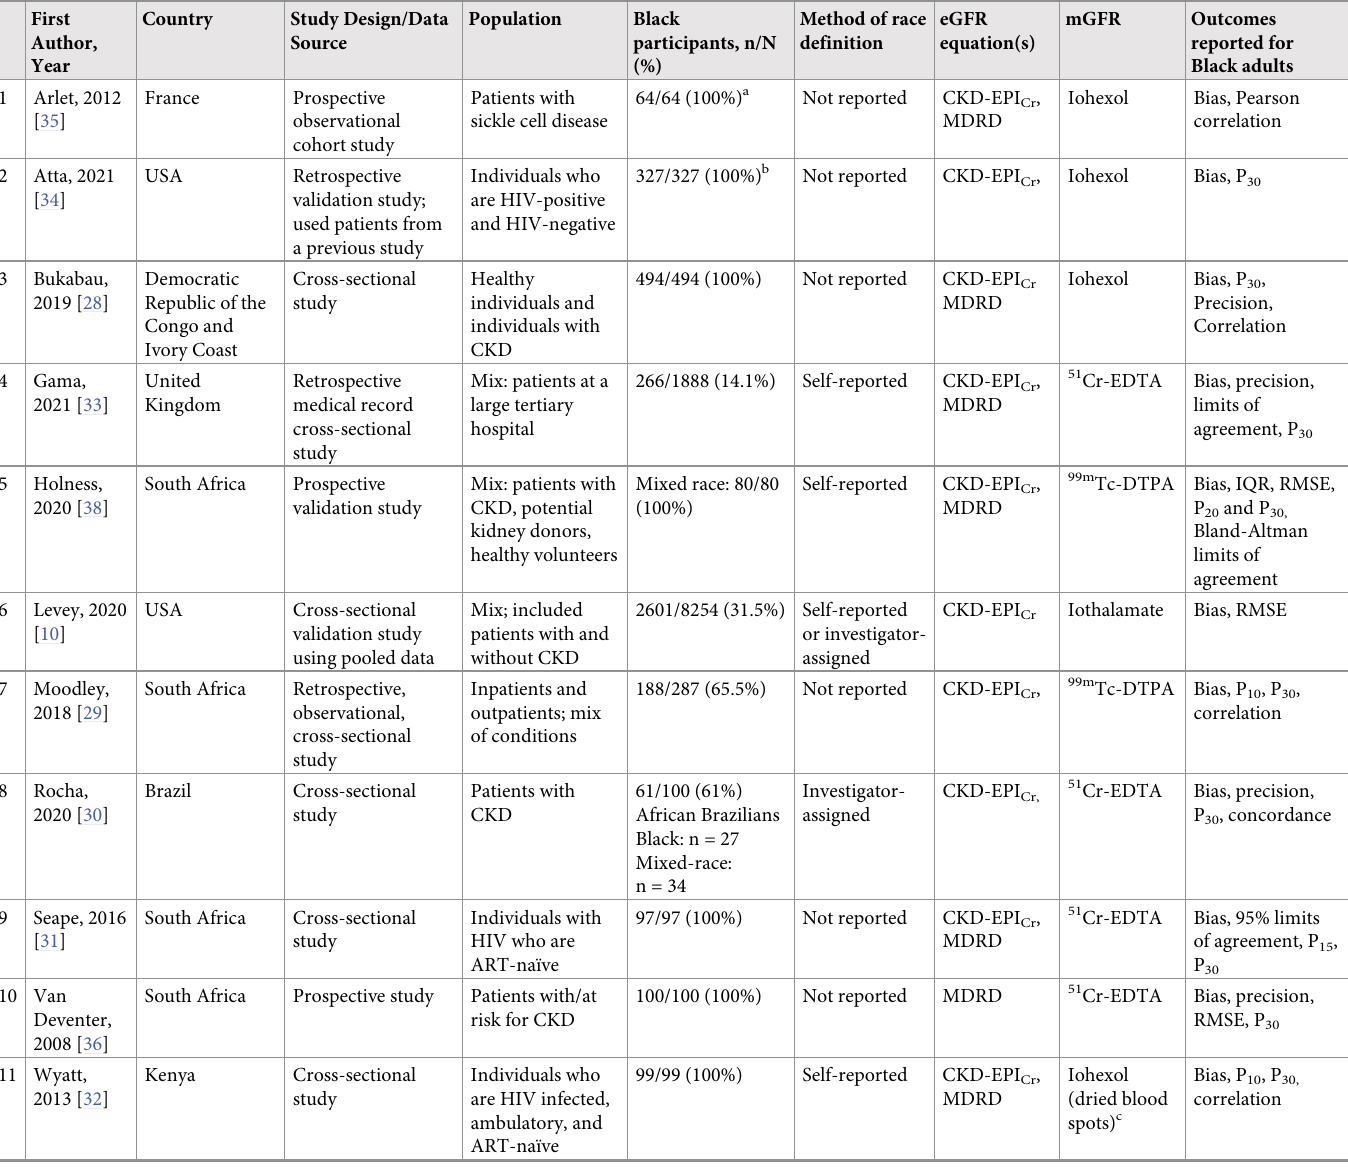
Table 1. Summary characteristics of studies included in the systematic review